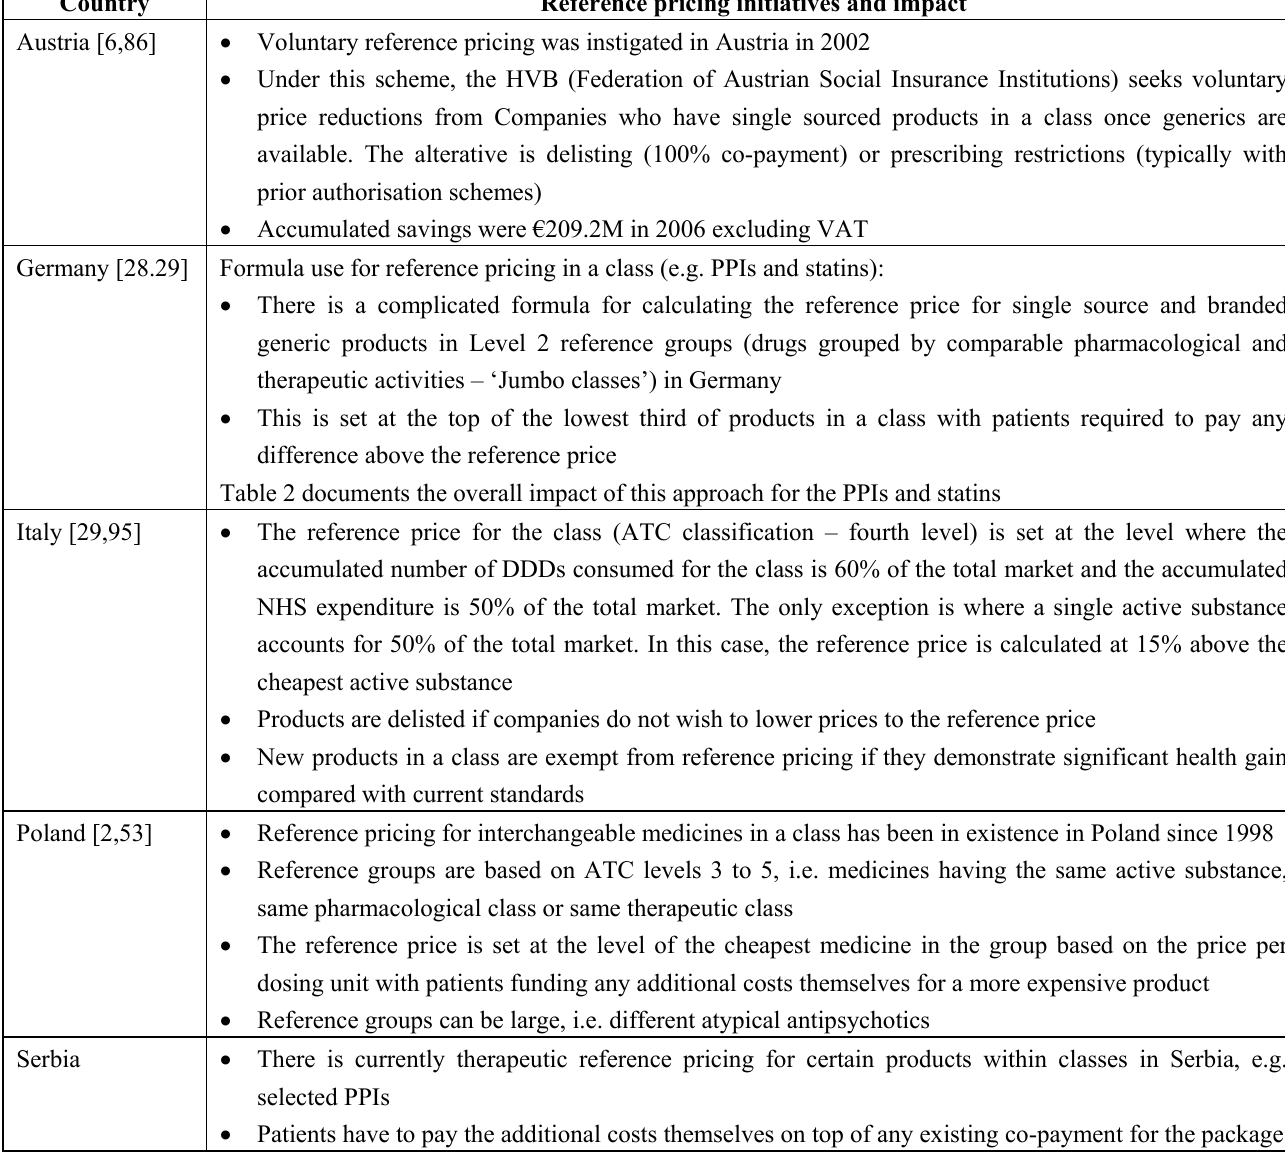
Table A5. Countries with reference pricing for the class among the selected European countries and the impact where